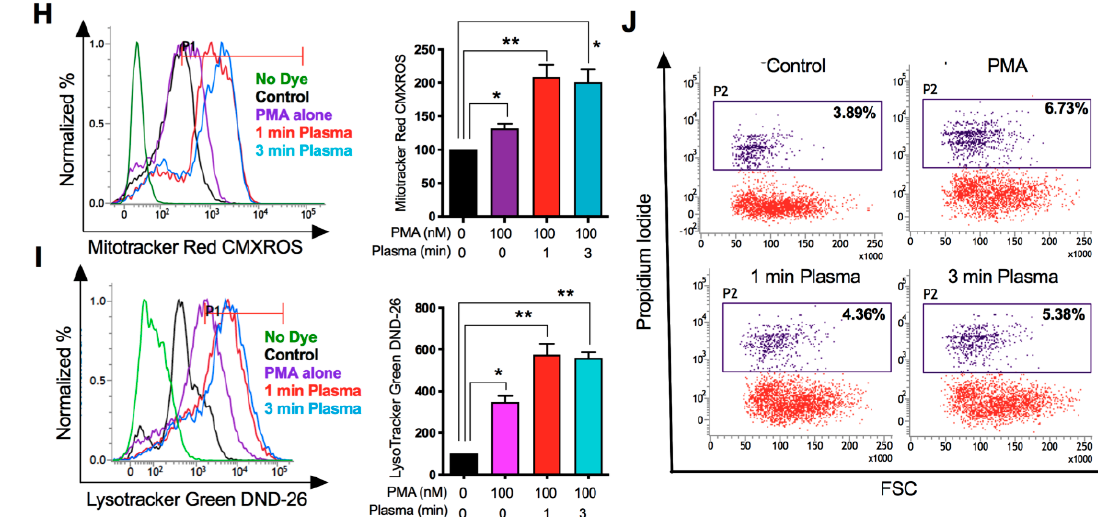
Figure 2. Characterization of cold plasma-stimulated macrophages. ( A ) To generate macrophage differentiation, human THP-1 monocytes were differentiated with PMA for 2 days, treated with cold DBD plasma for 1 min and 3 min on day 3 and further incubated for an additional 5 days. Polarized macrophages were observed using phase-contrast microscopy. Scale bar = 50 µm. ( B ) The quantitative determination of plasma-differentiated THP-1 cells is shown in the bar graph. ( C , D ) After plasma treatment, cell surface expression of CD86 (M1 marker) and CD163 (M2 marker) was analyzed by flow cytometry as shown in the histograms. Representative graph indicates the changes in macrophage cell surface markers followed by DBD plasma treatment. ( E ) QPCR analysis of the mRNA expression of the CD86, CD163, iNOS and ARG1 genes after 3-min plasma treatment in PMA-stimulated THP-1 cells. ( F ) Western blot analysis of the protein expression of the CD86, CD163, iNOS and ARG1 genes after control and 3-min plasma treatment in PMA-stimulated THP-1 cells. β -actin was used as a loading control. ( G ) Immunofluorescence staining of CD86 and CD163 in plasma-stimulated THP-1 cells. Scale bar = 10 µm. ( H , I ) The numbers of mitochondria and lysosomes were analyzed by staining with MitoTracker Red CMXROS and LysoTracker Green DND-26, followed by FACS analysis. ( J ) Cell death was assessed by propidium iodide (PI; 50 ng/mL) in PMA-treated THP1 cells after 1 min and 3 min of plasma treatment. Error bars represent mean ± S.D. of triplicate samples. * p < 0.05 and ** p < 0.01. Uncropped images are shown to Figure S1.